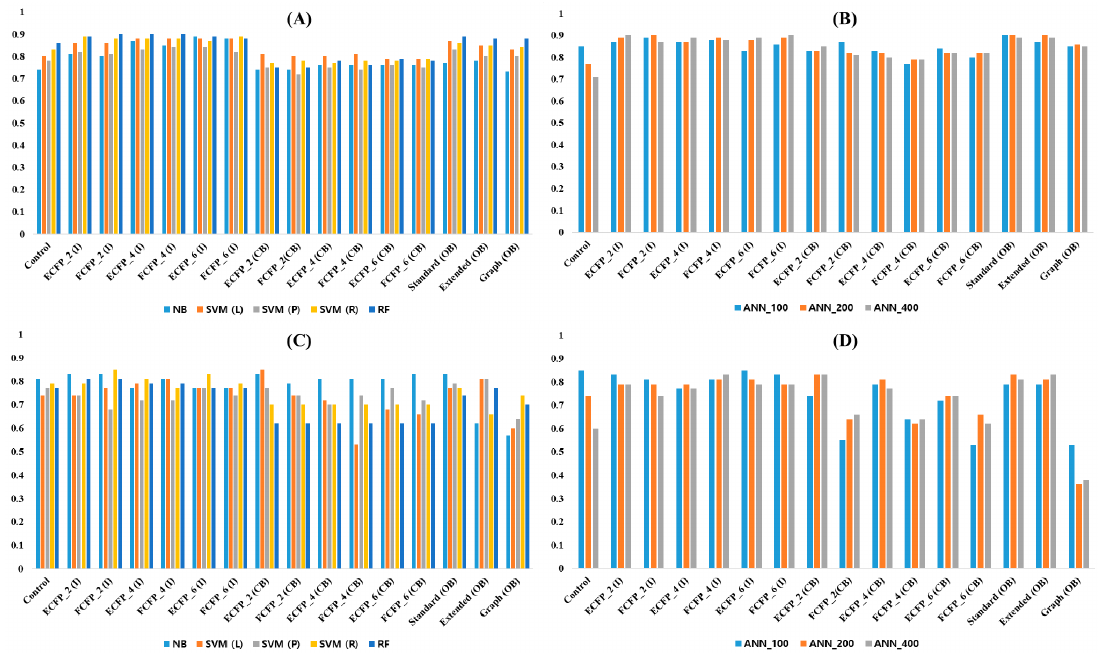
Figure 4. Model prediction to external sets. X-axis denotes fingerprint types whereas Y-axis